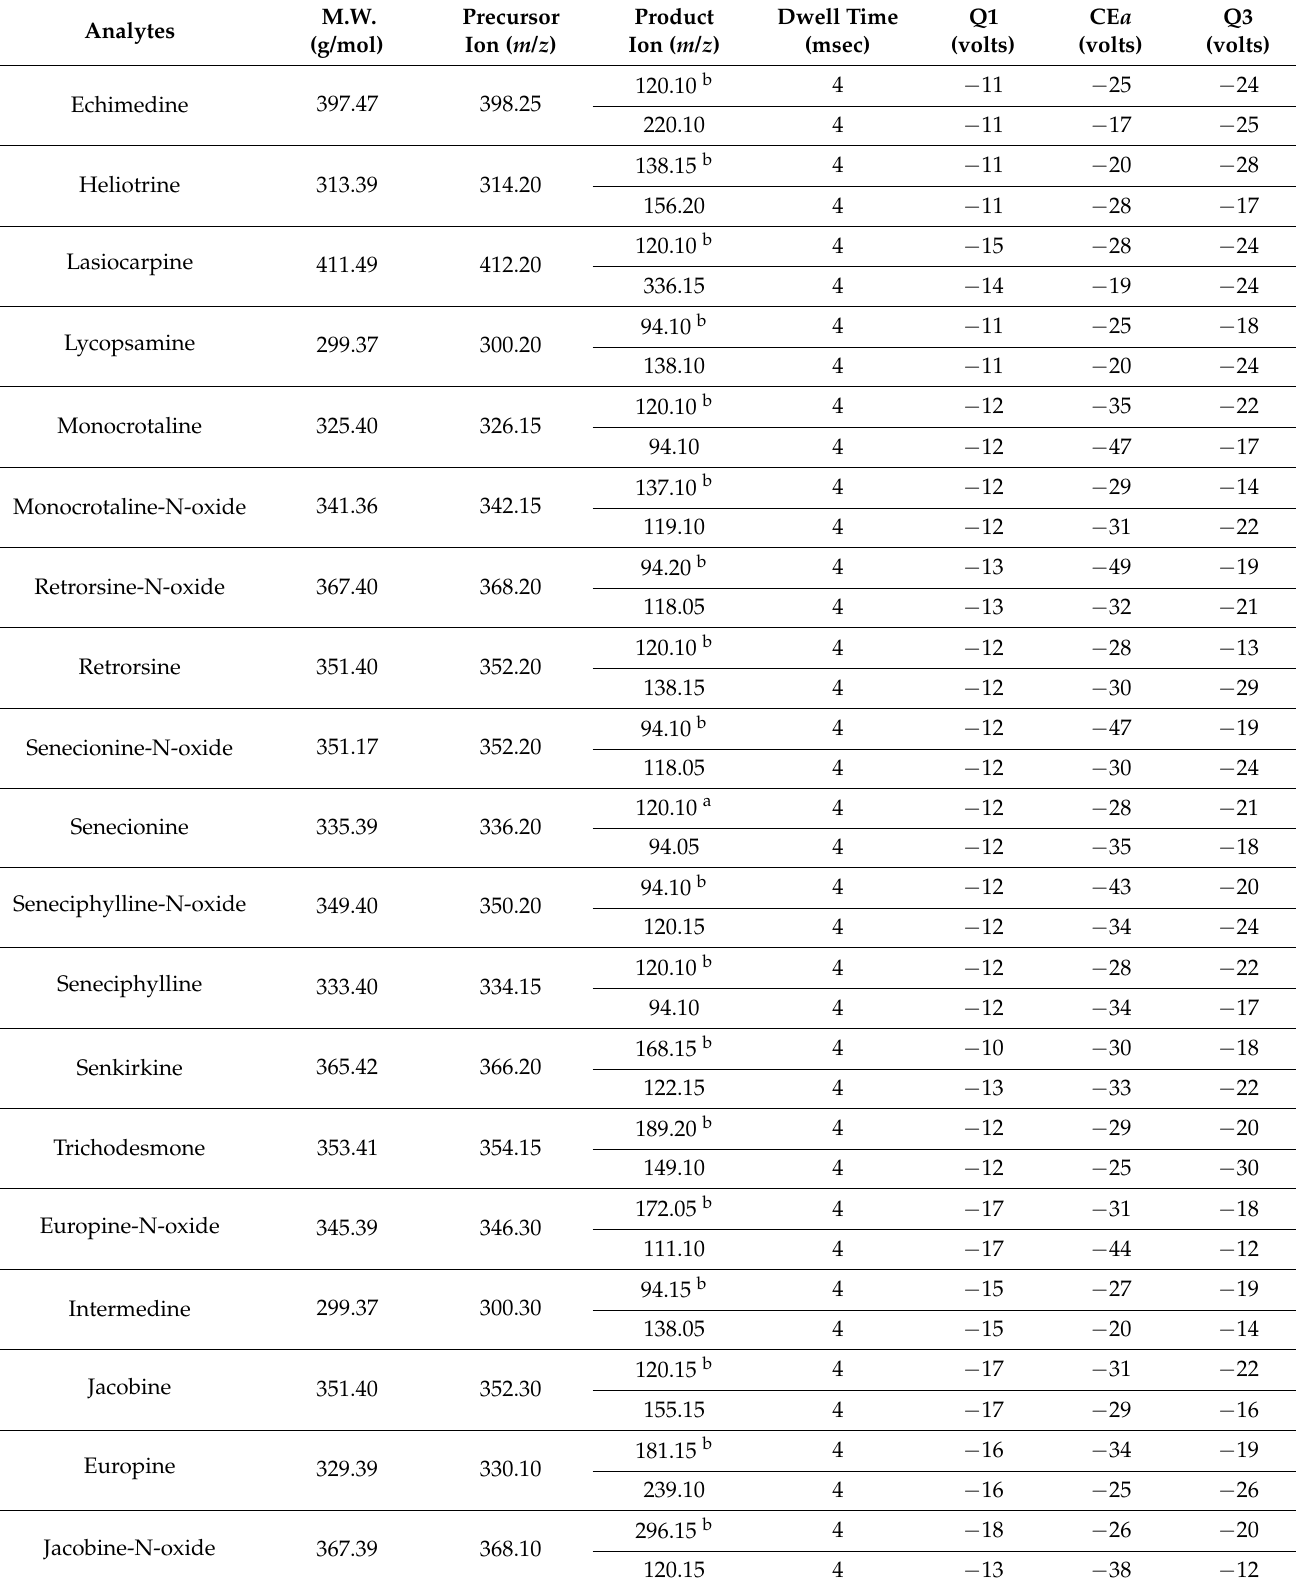
Table 1. Optimum parameters of MRM mode depending on PA